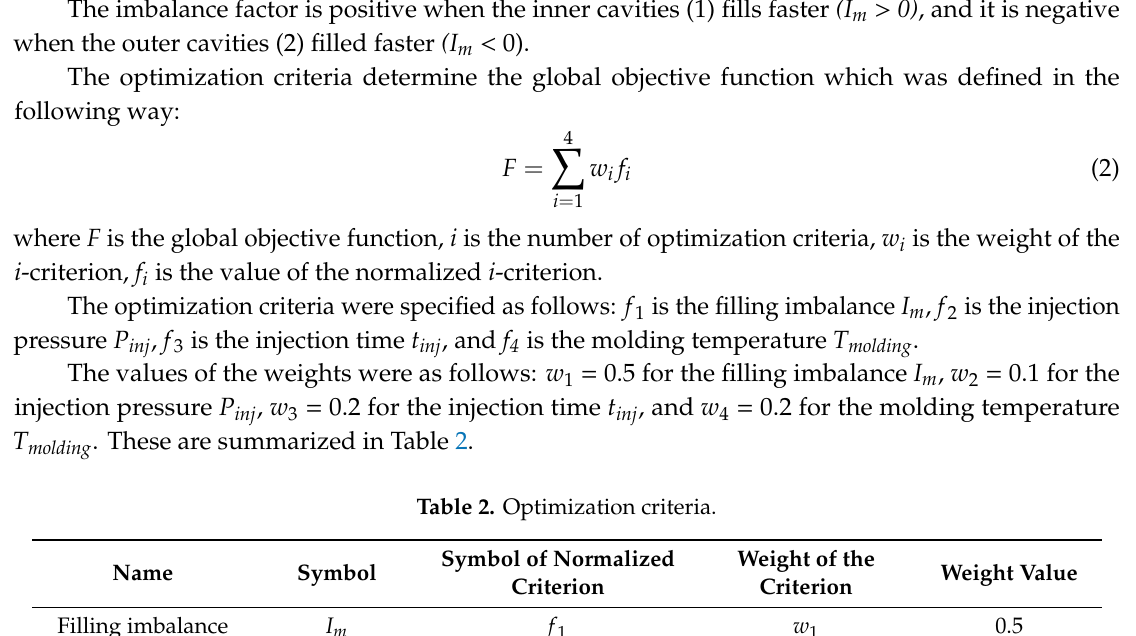
Figure 3. The concept of mass filling imbalance coe ffi cient: ( a ) positive imbalance, I m > 0 ( m 1 > m 2 ), faster filling of inner cavities; and ( b ) negative imbalance, I m < 0 ( m 1 < m 2 ), faster filling of outer cavities.